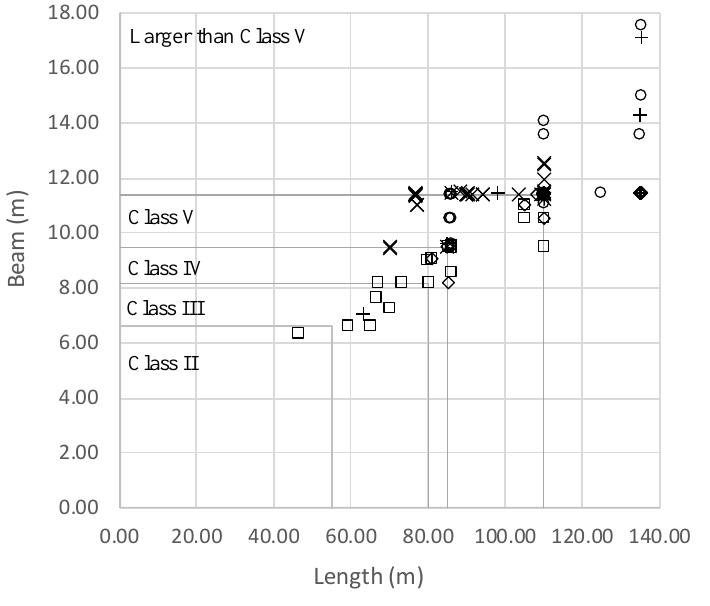
Figure 3. Selection of 124 ships included in regression